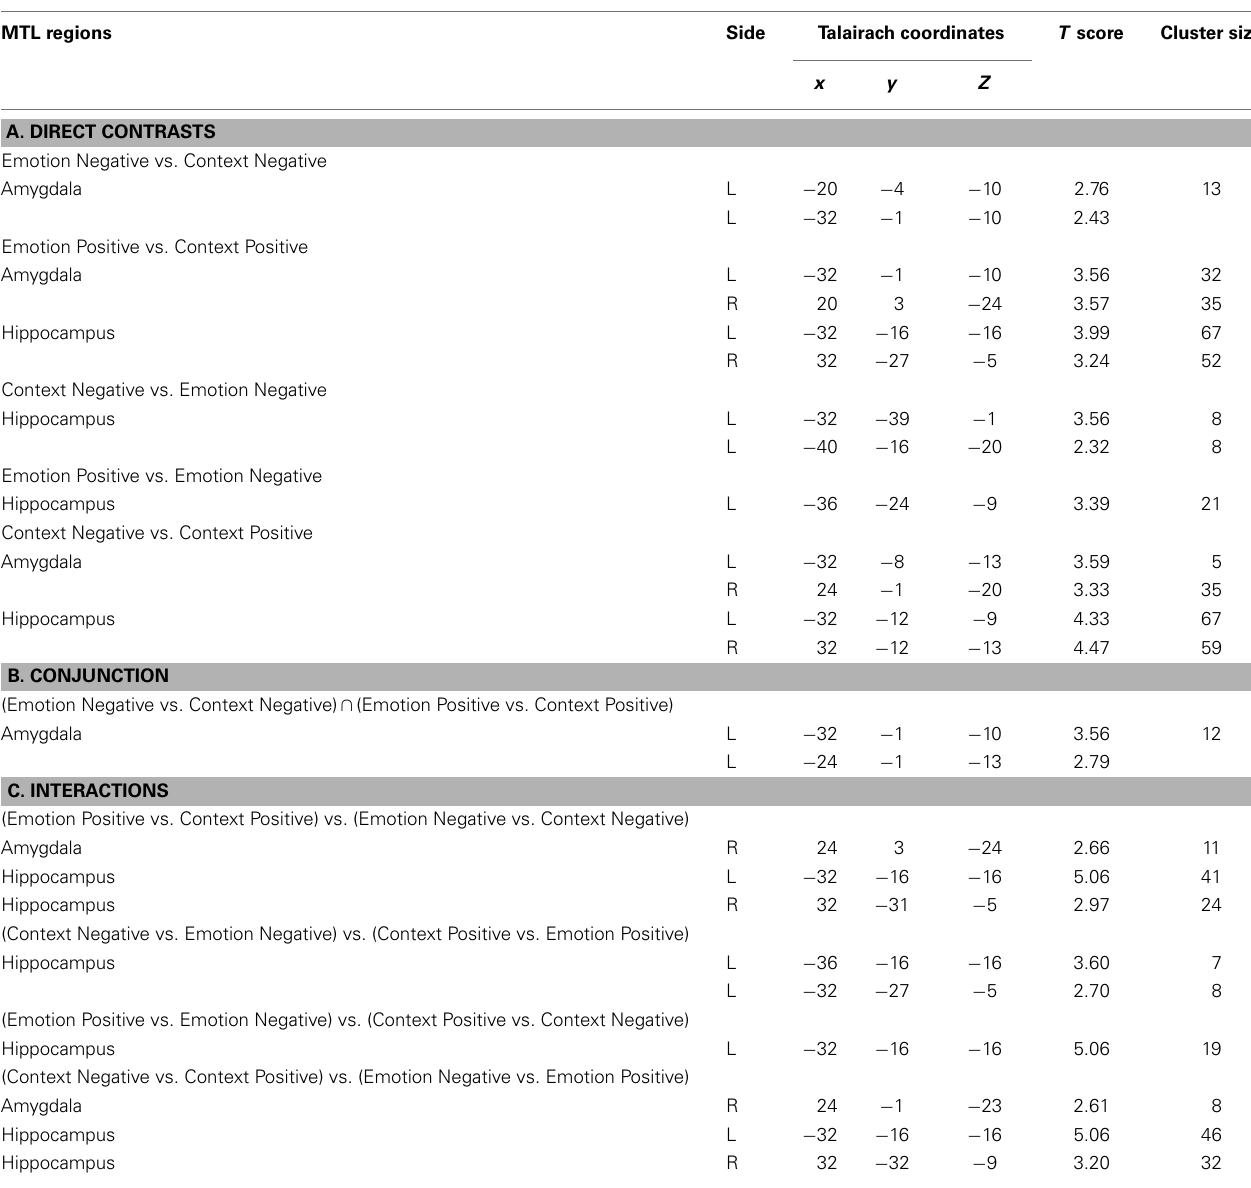
Table 2 |Activations in MTL ROIs linked to the retrieval focus and emotional valence of